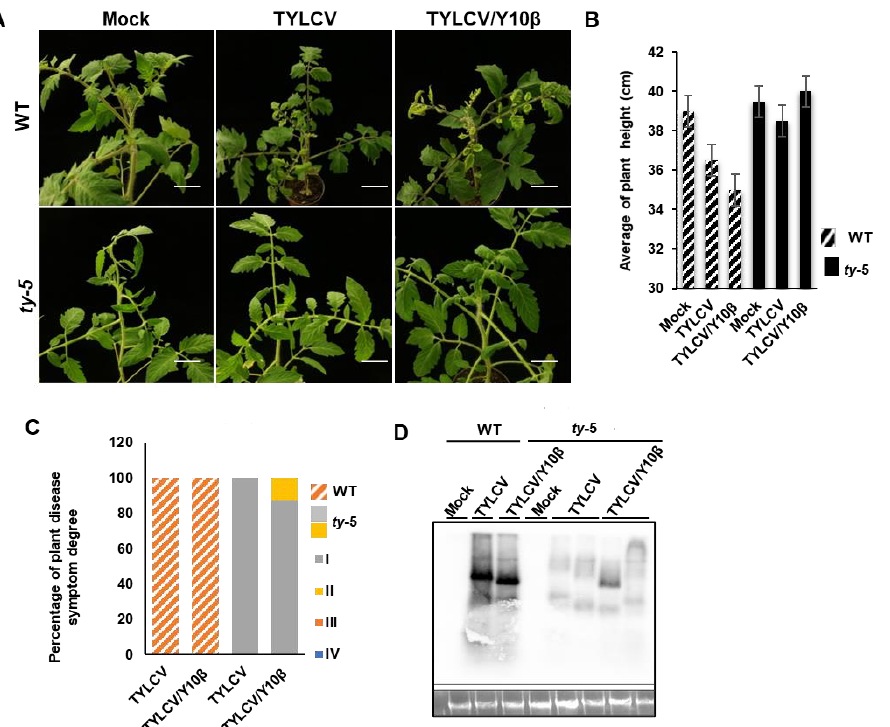
Figure 4. ty-5 confers resistance to tomato yellow leaf curl virus (TYLCV) with a betasatellite. ( A ) Viral symptoms of the tomato ty-5 line and wild-type (WT) line agroinfected with either the pBinPLUS empty vector (mock), an infectious clone of TYLCV, or infectious clones of TYLCV/to- mato yellow leaf curl China betasatellite (Y10 β ). The mock- and virus-inoculated plants were pho- tographed at 7 weeks post-inoculation (wpi). ( B ) The mean height of WT and ty-5 plants infected with TYLCV, with and without a betasatellite, at 7 wpi. ( C ) The percentage of degree of disease symptoms in WT and ty-5 plants infected by TYLCV, with and without a betasatellite at 7 wpi. Fifteen plants from each of the WT and ty-5 lines were used for the assays. Disease symptoms were classified from grade I (no symptoms) to grade IV (very severe symptoms). ( D ) Southern blotting analysis of viral DNA accumulation in WT and ty-5 lines infected by TYLCV or TYLCV/Y10 β at 7 wpi. A DNA fragment of TYLCV capsid protein was used as a probe for detection of genomic DNA from TYLCV.